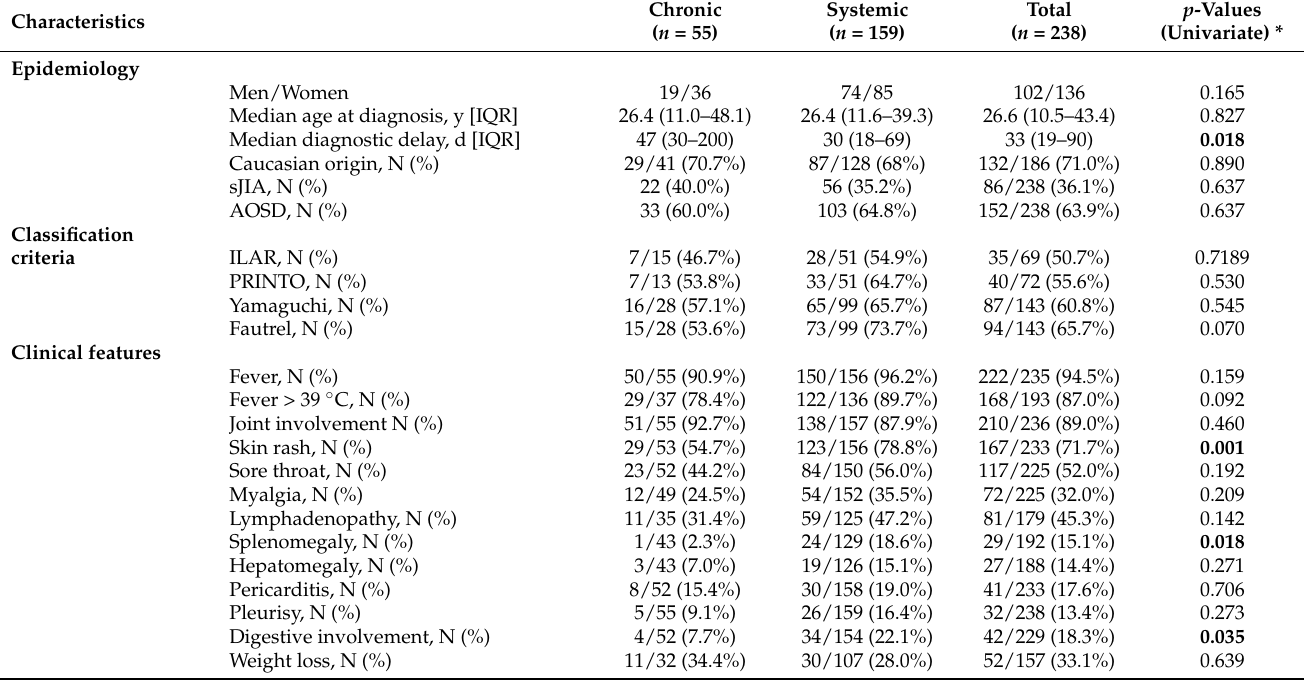
Table 1. Epidemiological and clinical characteristics according to the disease